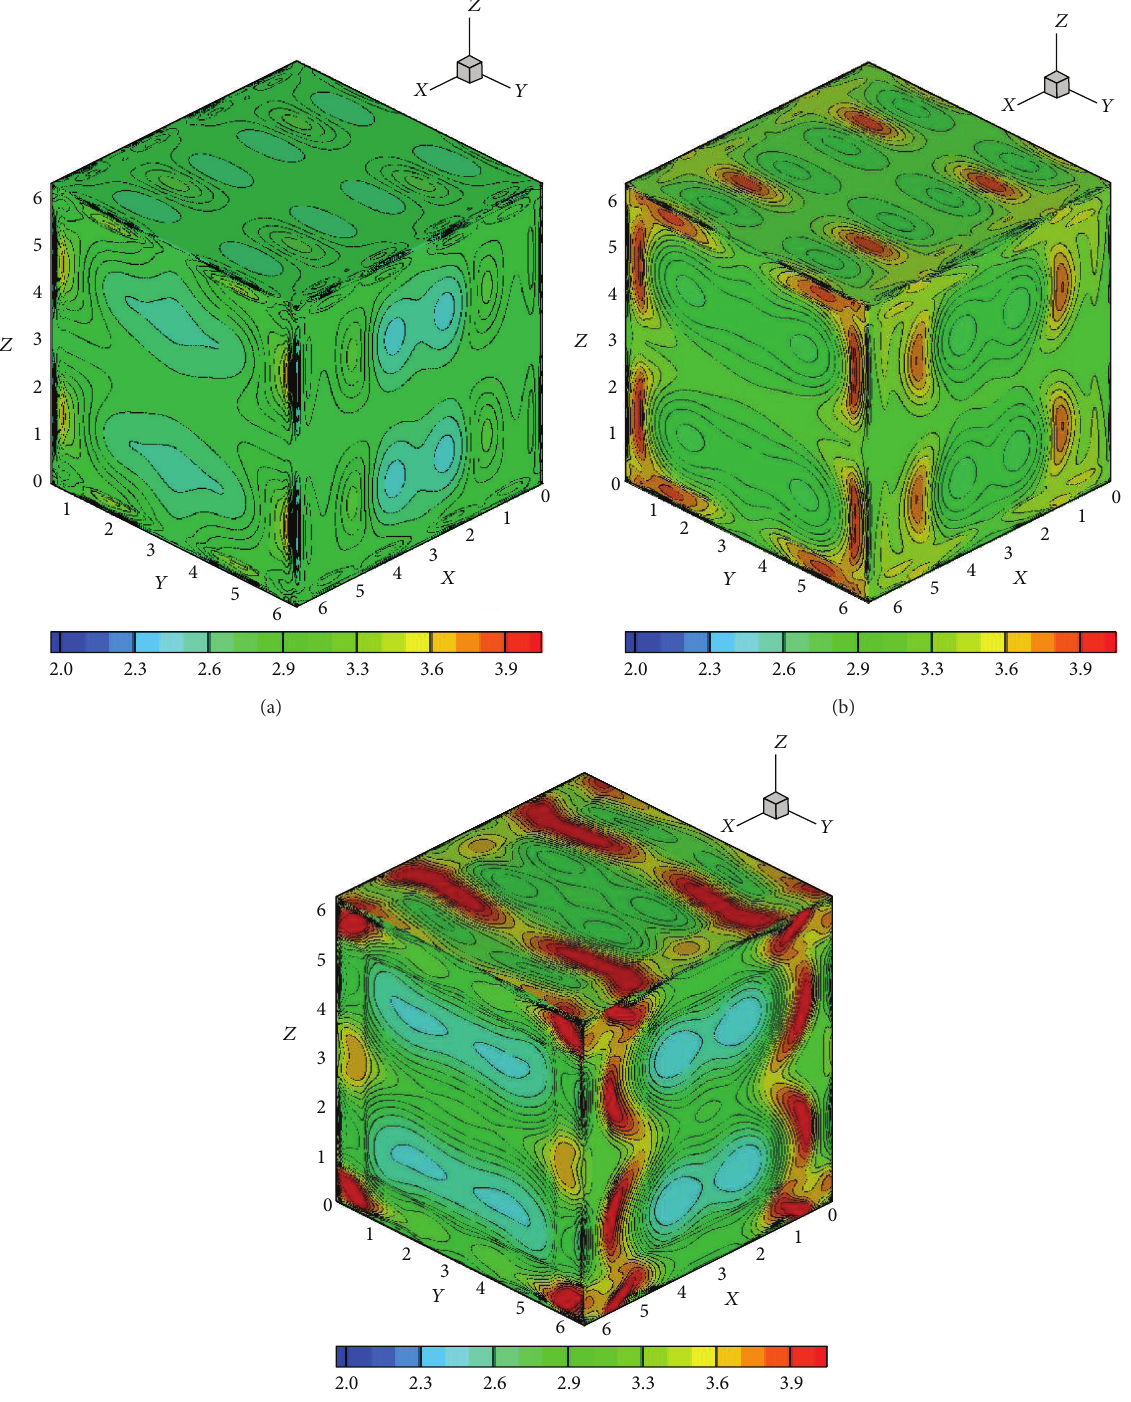
Figure 14: Instantaneous contours of density across 𝑥 -, 𝑦 -, and 𝑧 - direction centerlines ( = 𝜋 ) at (a) 𝑡 = 0.2 , (b) 𝑡 = 0.4 , and (c) 𝑡 = 0.8 (grid: 256 3